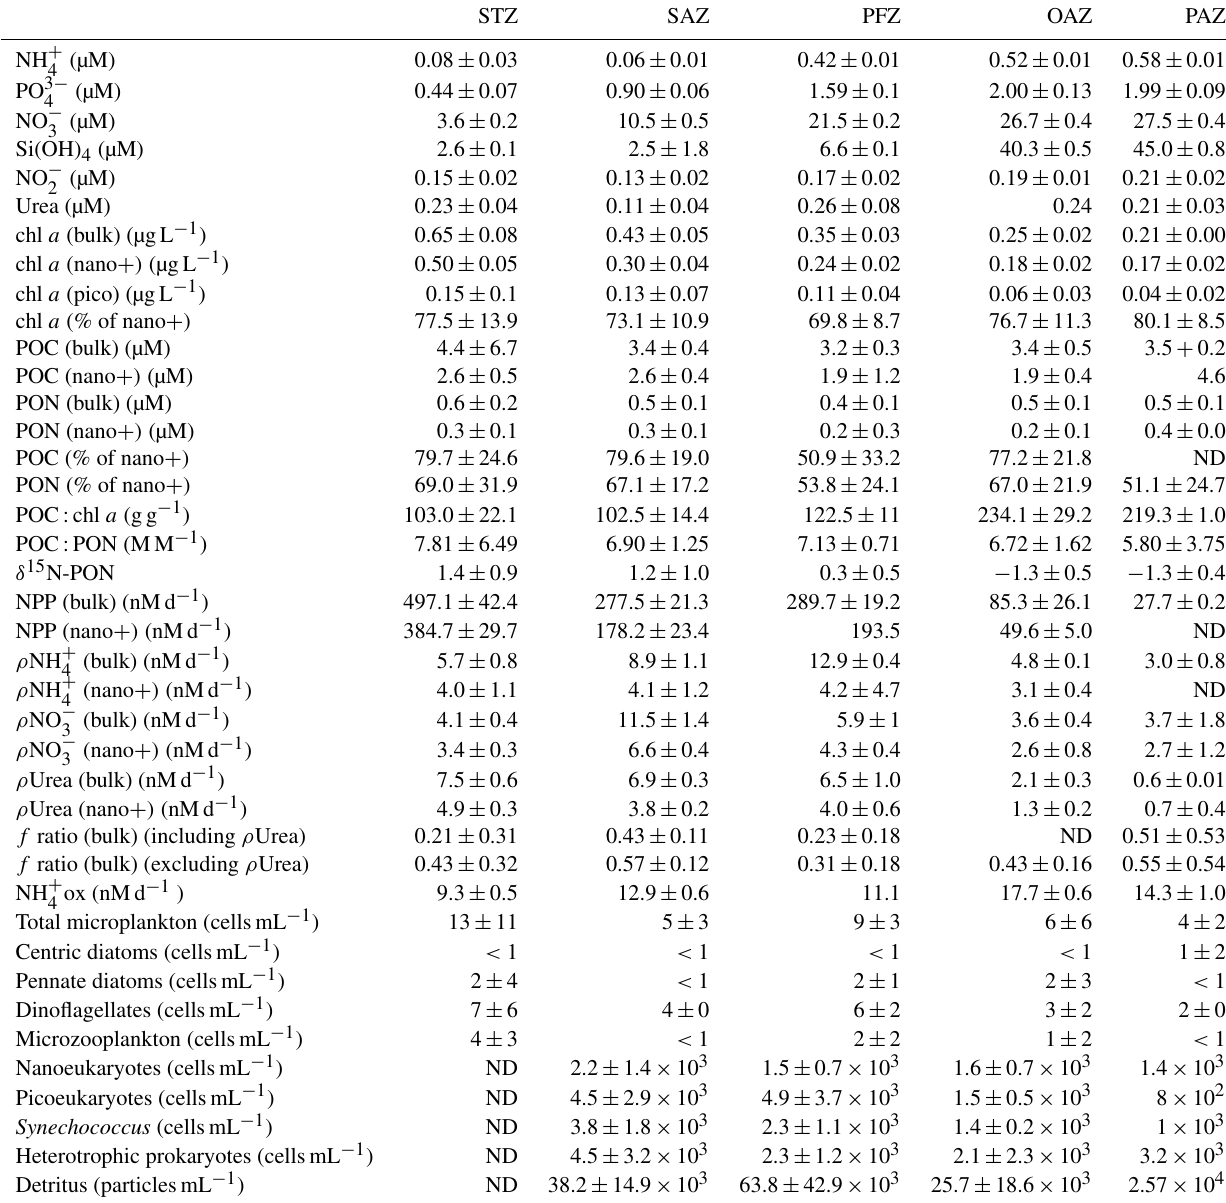
Table 1. Mean ( ± 1SD) of surface ocean POC, PON, chl a , and nutrient concentrations, cell abundances, and nutrient uptake rates measured in each zone of the Southern Ocean in winter 2017. Where no SD is given, only one sample was measured. The > 0.3µM and > 2.7µm size fractions are referred to as bulk and nano + , respectively. “% of nano + ” refers to the average relative contribution of the nano + size fraction to total chl a , POC, or PON, calculated for each station within a zone. The f ratio including ρ Urea is shown only for zones where ρ Urea was measured at all stations. “ND” indicates no data available. Abbreviations are as in Fig.